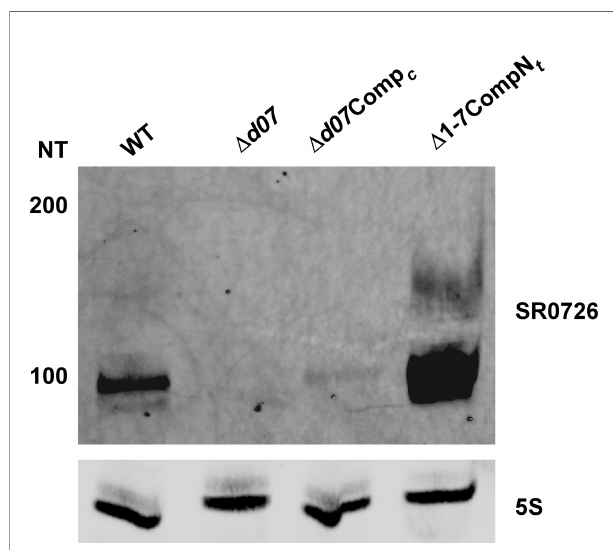
FIGURE 7 | Con fi rmation of SR0726 transcript size. Northern blot of total RNA extracted from in vitro grown wild type, D d07 , D d07 Comp c , and SR0726 overexpression strain (CompN t ). 5S rRNA serves as the loading control for each